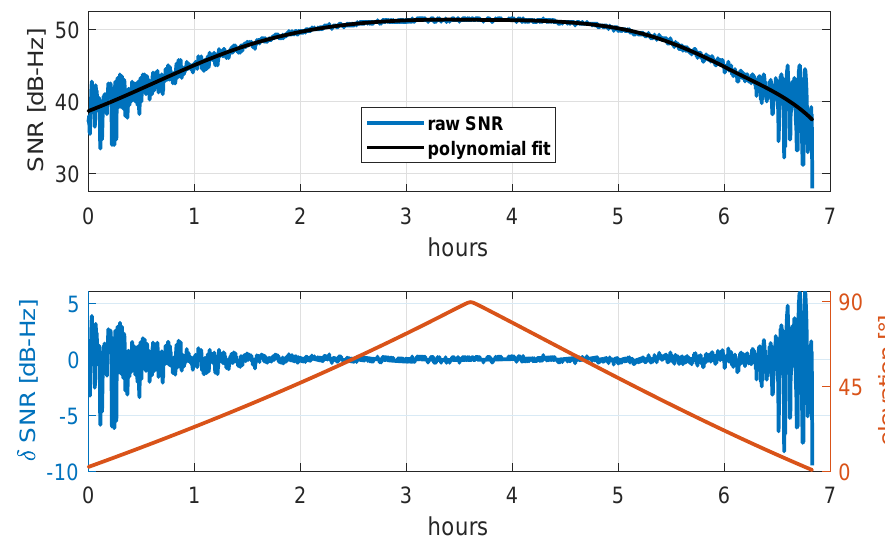
Figure 4. ( Top ) Raw signal-to-noise ratio (SNR) time series (blue) and polynomial fit (black) representing A D . ( Bottom ) δ SNR (blue) representing A M , after subtracting the polynomial fit from the raw SNR values, and related satellite elevation (red).